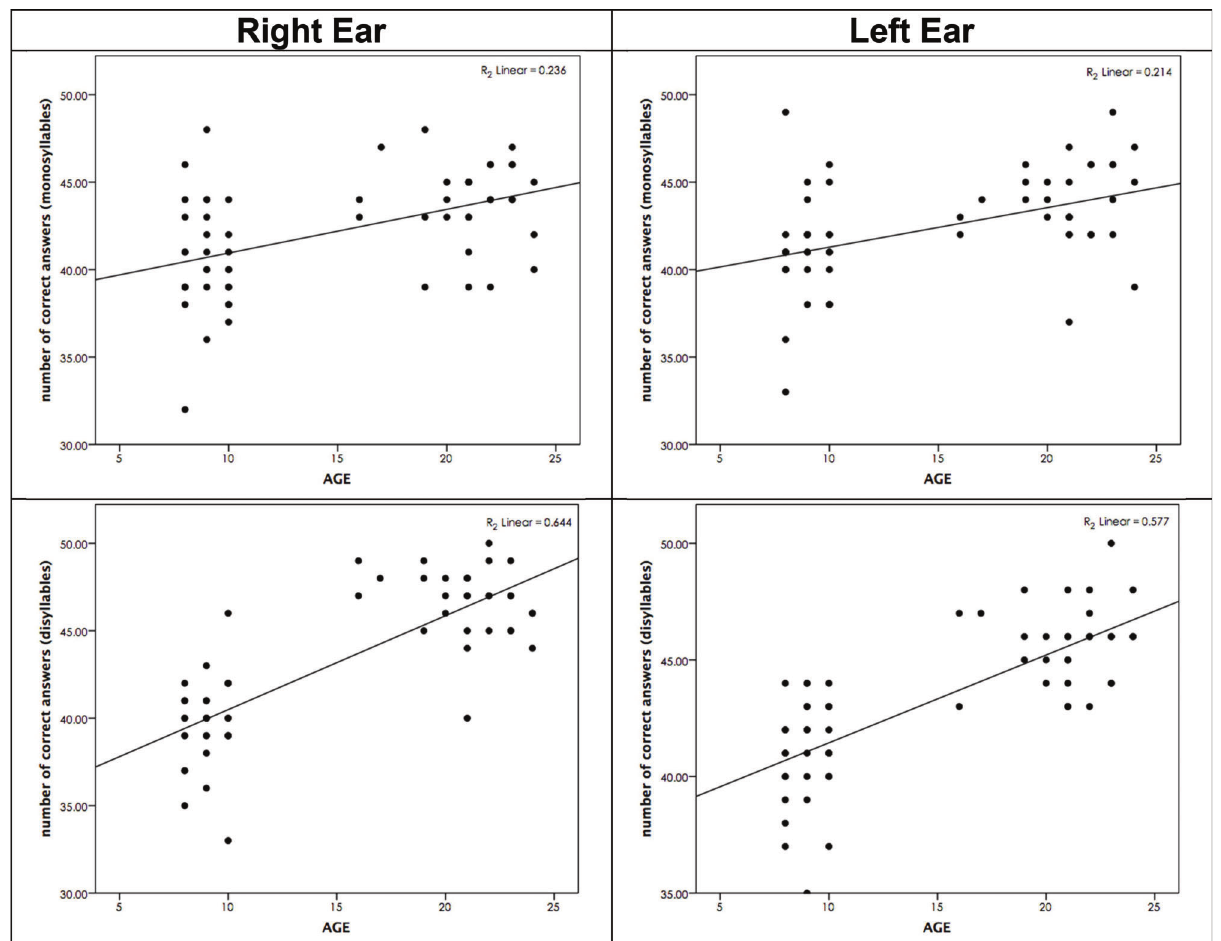
Figure 3 - Linear regression showing the relationship between age and TCS performance per